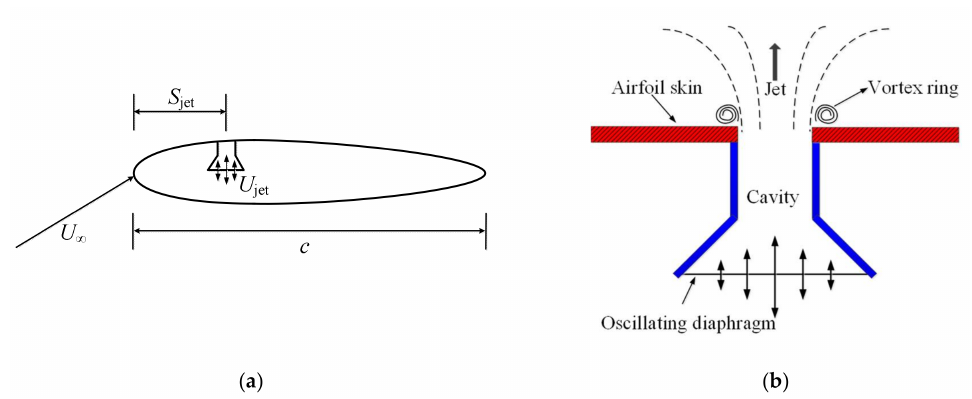
Figure 2. Side view of the morphing wing. ( a ) Synthetic jet-based airfoil and ( b ) synthetic jet actuator.